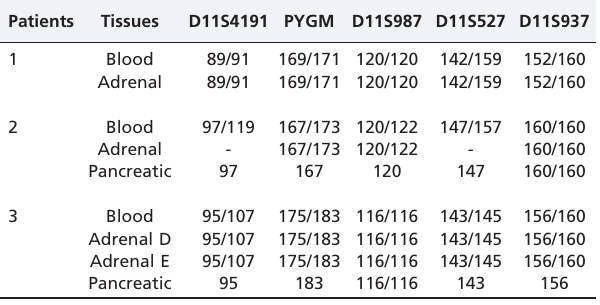
Supplementary Table 1- Allelic distribution of the five microsatellite markers used in the LOH study of MEN1 syndrome patients.